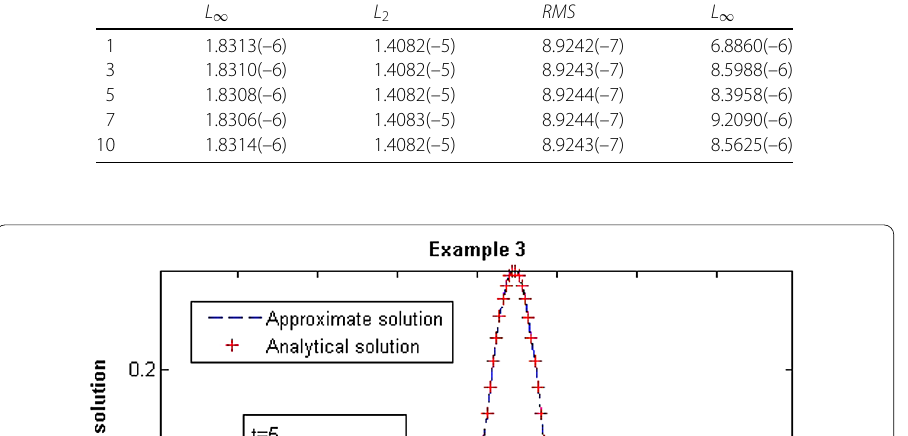
Table 7 L ∞ , L 2 and RMS errors for p = 100, σ = 1 and comparison of L ∞ error with [5] for Example 3